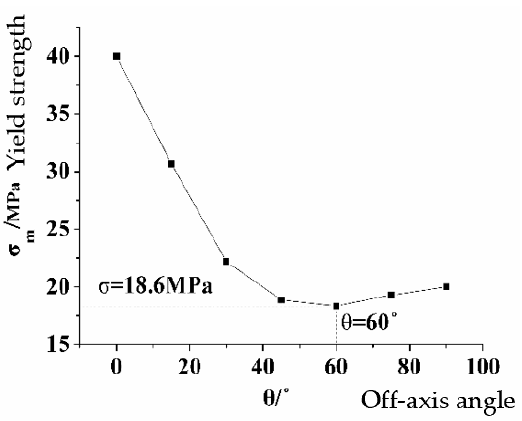
Figure 3. Relationship between yield strength and off-axis angle.